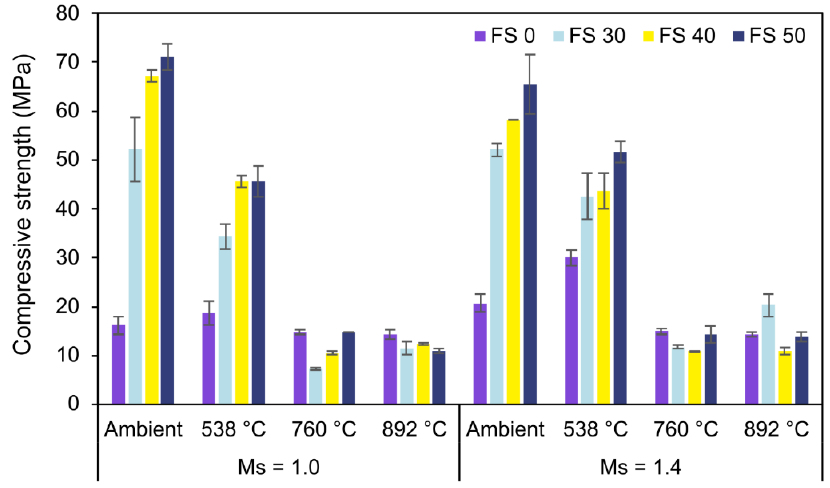
Figure 24. Compressive strength results.